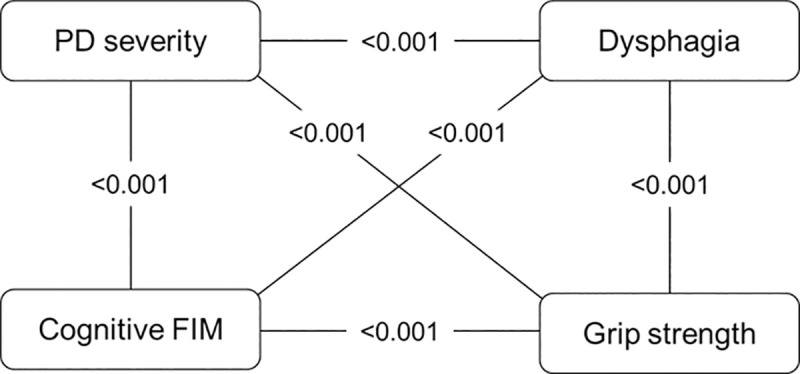
Relationships of the four confounding factors.The values in the figure represent the p-value between the two variables. PD, Parkinson’s disease; FIM, Functional Independence Measure.